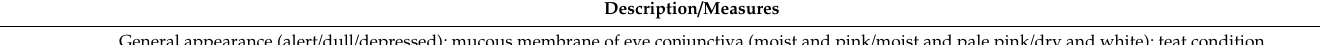
Table 2. Parameters measurement and methodology of data collection for the assessment of health of the selected dairy cows based on animal parameters used in the Welfare Quality ® assessment protocol (Welfare Quality ® ,